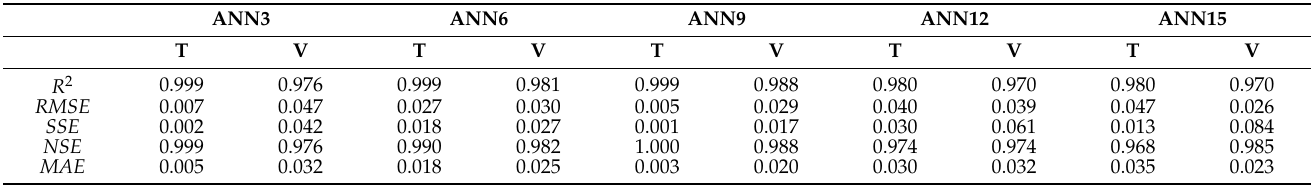
Table 4. Performance evaluation of the assessed ANN